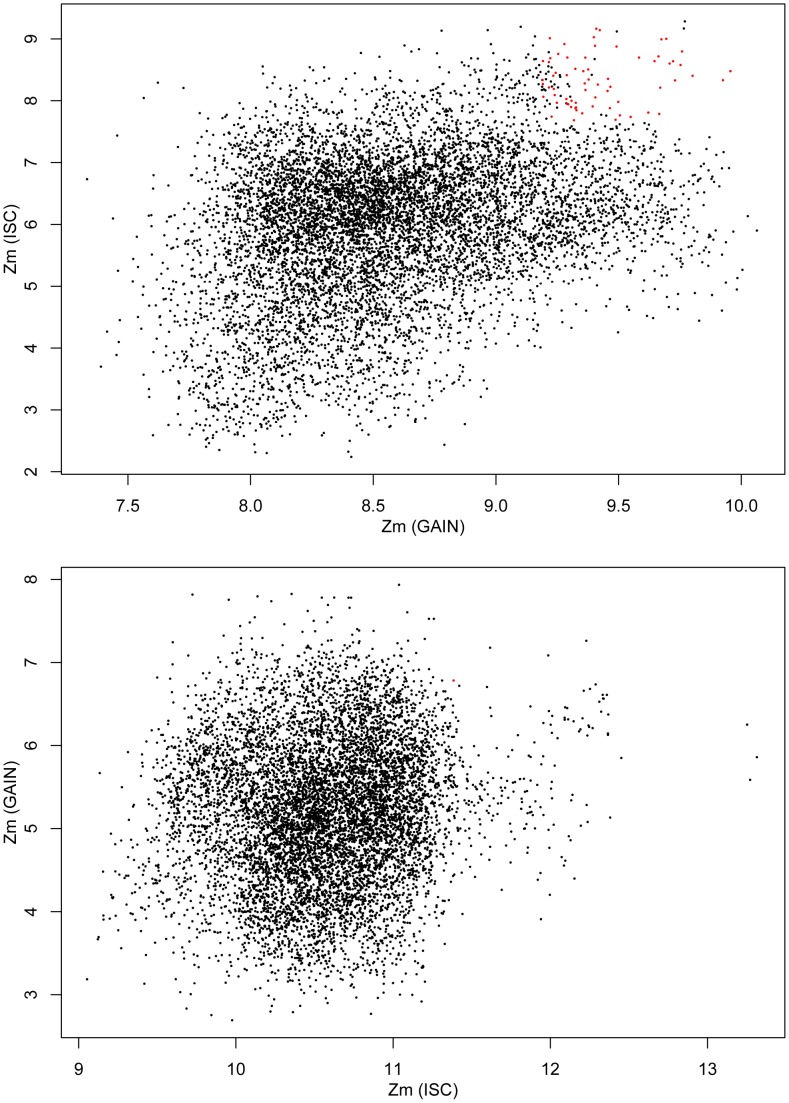
Distribution of module scores (Zm) from two GWAS datasets.Each circle in the plot represents a module. The circles in red indicate those selected modules (see text). X-axis: module scores from the discovery GWAS dataset. Y-axis: module scores from the evaluation GWAS dataset.